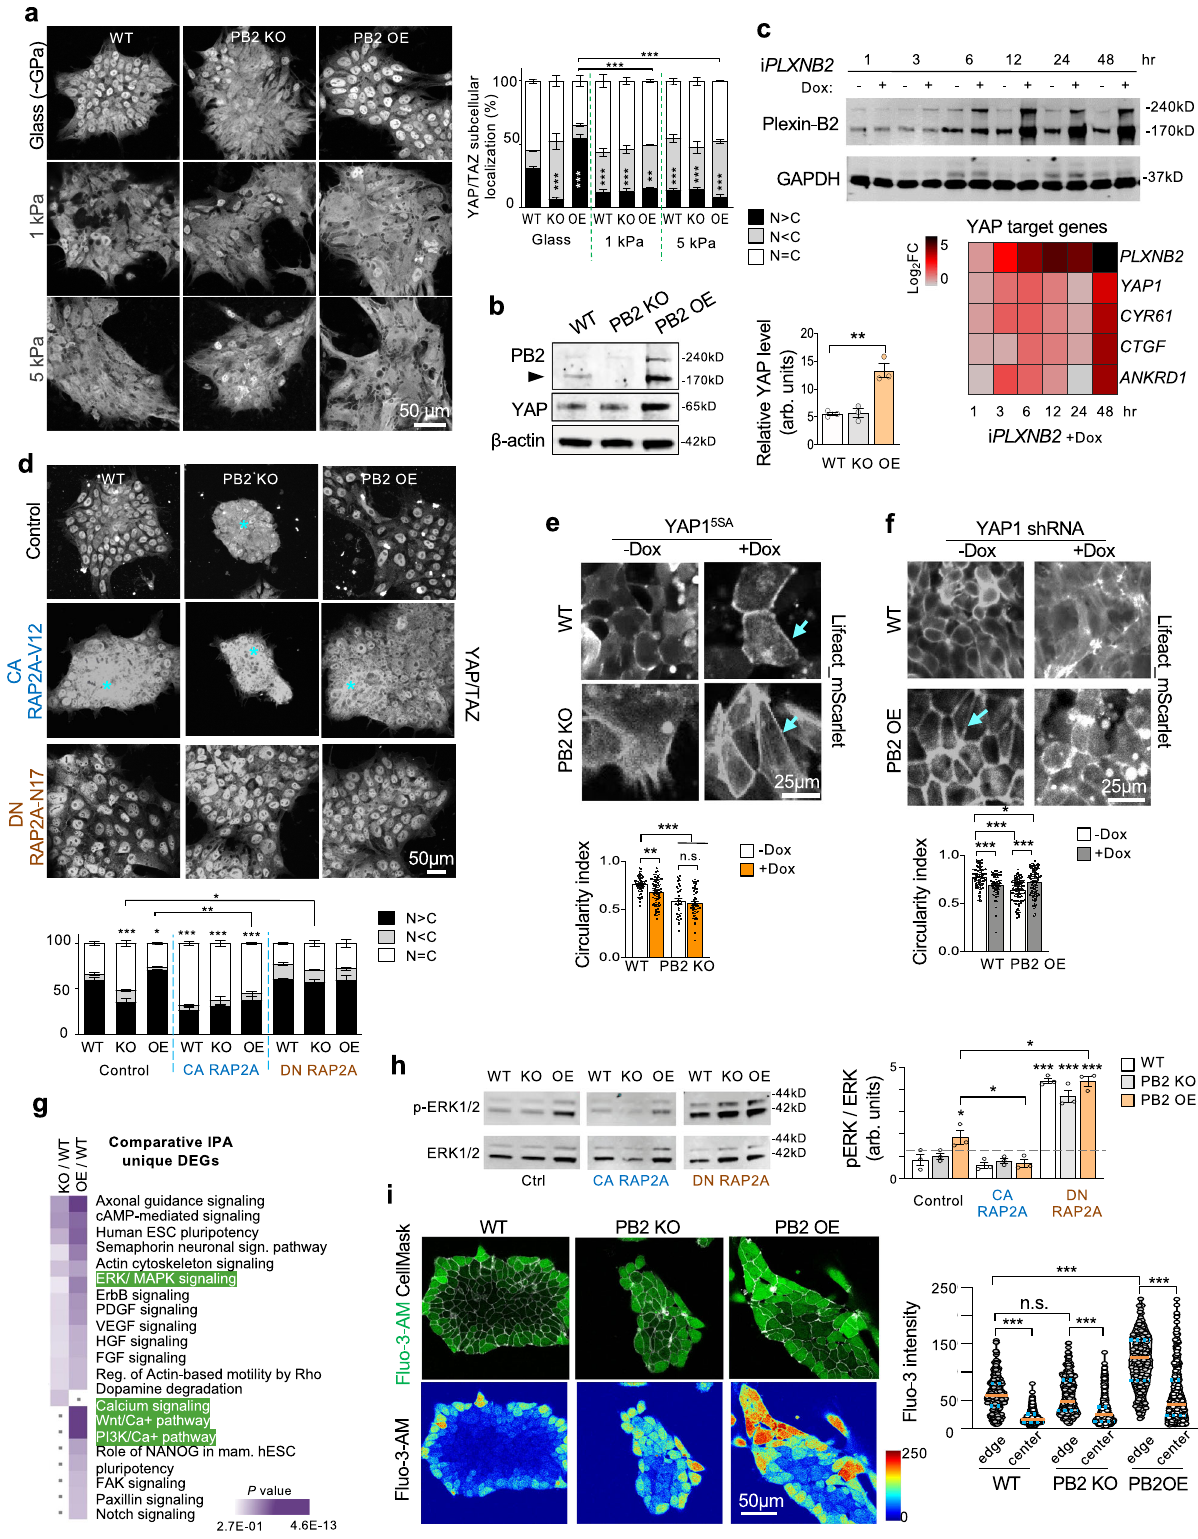
compared to WT counterparts, as evidenced by enhanced induction of the neuroblast marker doublecortin (DCX) and the neuronal marker β -III tubulin, and reduced expression of NPC markers PAX6 and SOX2 (Figs. 8c and S13b, c). Analyses by qRT-PCR con fi rmed upregulation of TUBB3 (encoding β